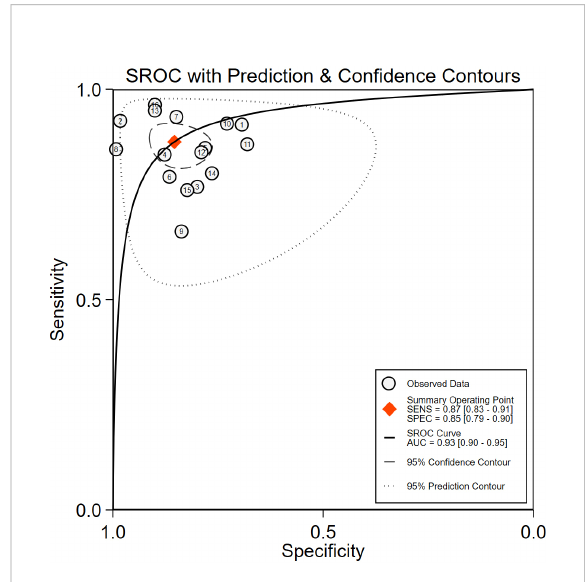
FIGURE 5 The receiver operating characteristic curve (ROC). SENS, sensitivity; SPEC, speci fi city; SROC, summary receiver operating characteristic curve; AUC, area under the SROC